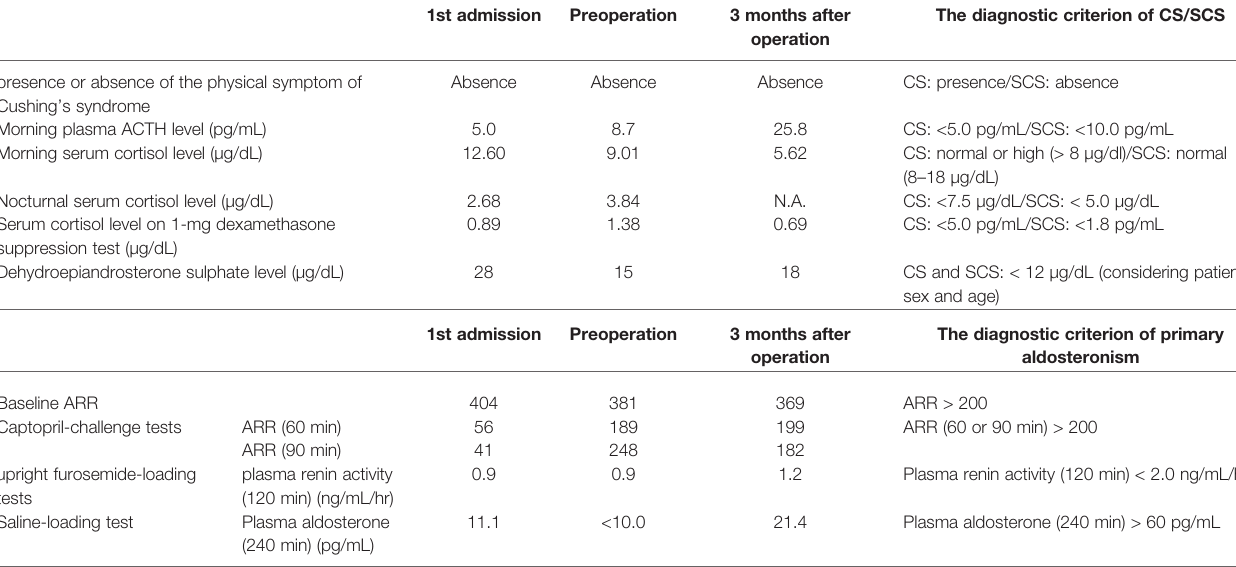
TABLE 1 | Summary of endocrine disorders of the